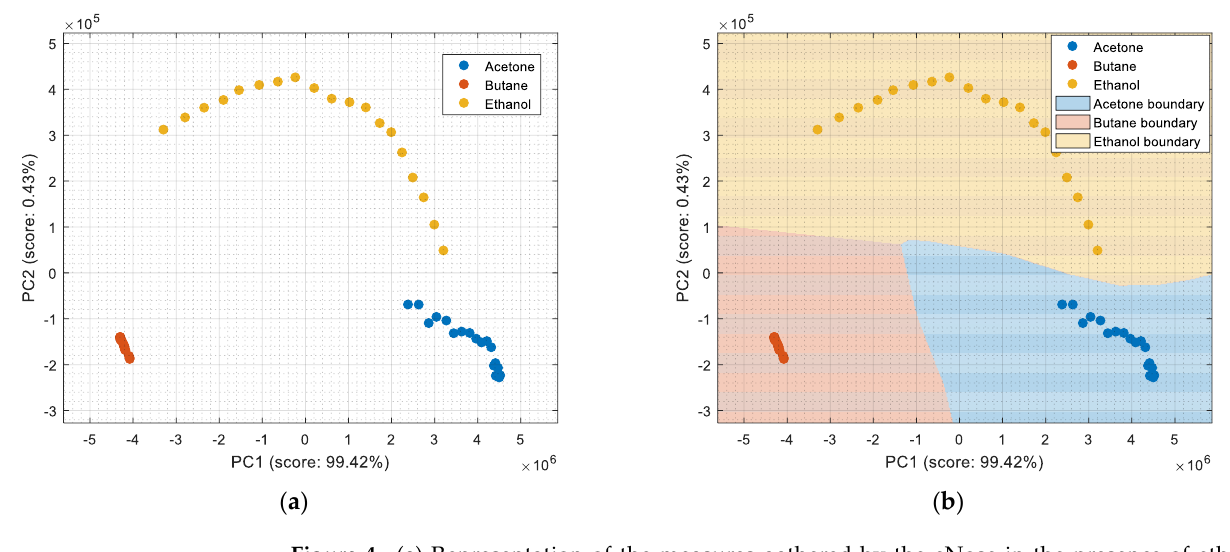
Figure 4. ( a ) Representation of the measures gathered by the eNose in the presence of ethanol (yellow), acetone (blue), and butane (orange) projected in the two principal components defined by the PCA analysis. ( b ) The same representation including a class-map visualization that illustrates the boundaries defined by a k -NN classifier applied to the PCA projection results.